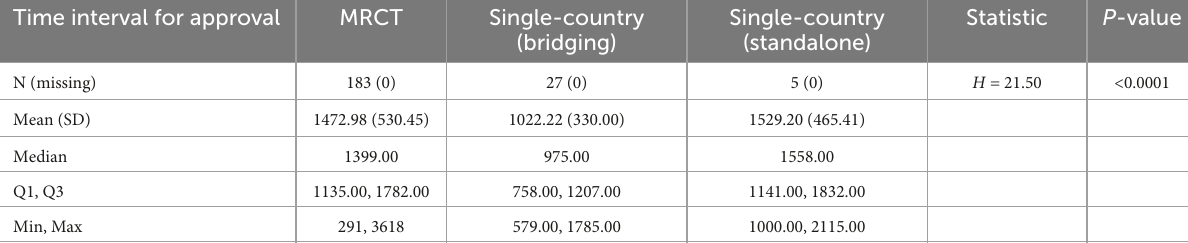
TABLE 8 Time interval for approved oncology drugs between MRCTs and single-country trials. Time interval for